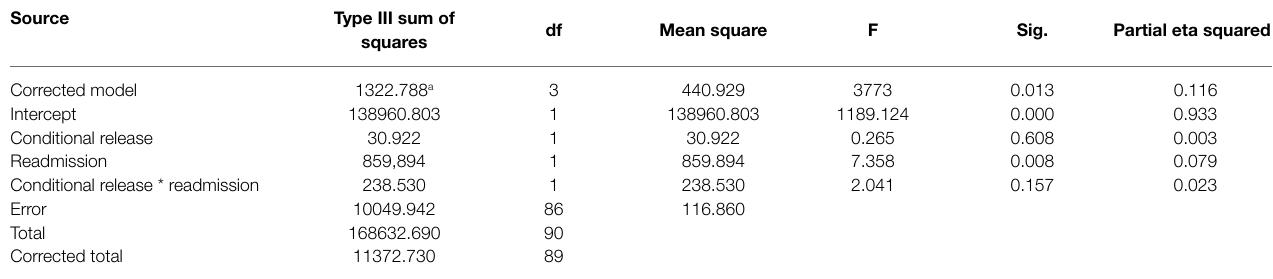
TABLE 4 | Tests of between-subjects effects – dependent variable: Age (years) at first discharge.